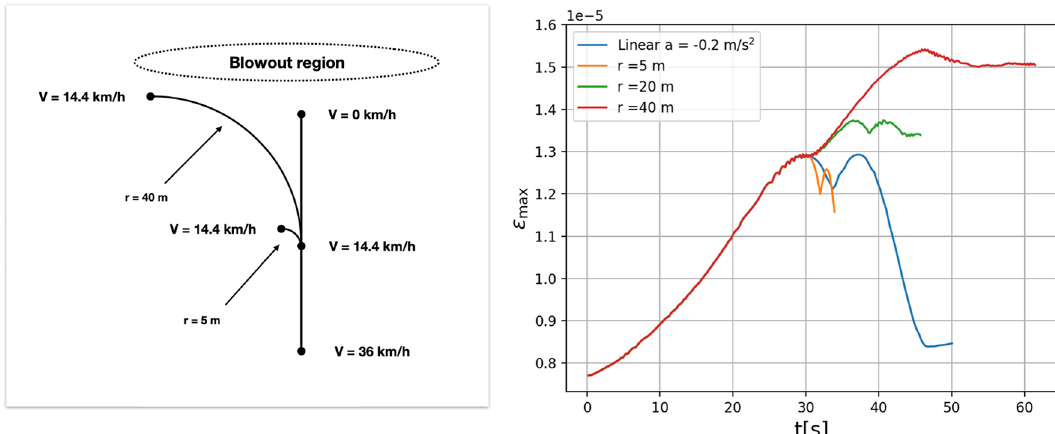
Figure 6. Navigating a blowout. Left panel: Different routes of a vehicle aiming to avoid an obstruction in the ice. The vechicle first slows from 34 to 14 km/h on a linear path. Then there are three options: a path with radius 5 m, a path with radius 40m, or a continued linear path and continued deceleration at a constant rate of a 0.2 m/s. Right panel: Maximum strain as a function of time for a 1000 kg vehicle continuing in a straight = − path and slowing down, or tracing out curves at various angles without slowing down